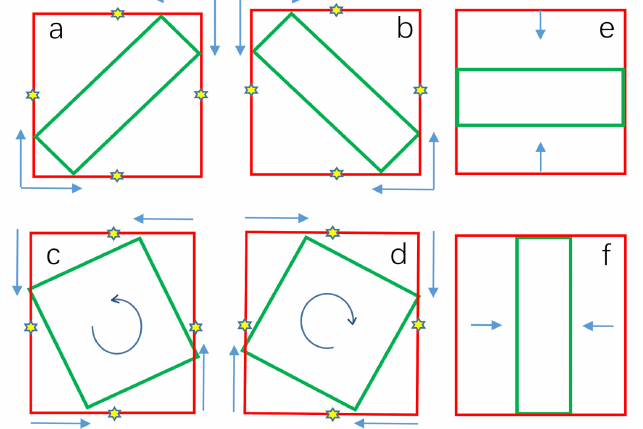
Figure 4. Subfigure ( a – d ) detail the four possible regression branches. Subfigure ( e ) and subfigure ( f ) can be regarded as special cases whose sliding ratios are close to 0. The yellow star represents the midpoint of the boundary of the circumscribed